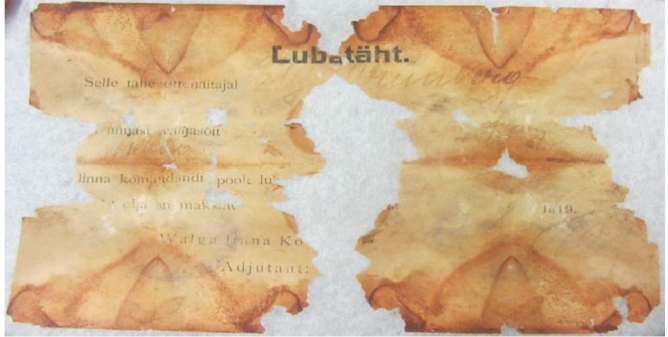
Figure 2. “Lubatäht” (Permission